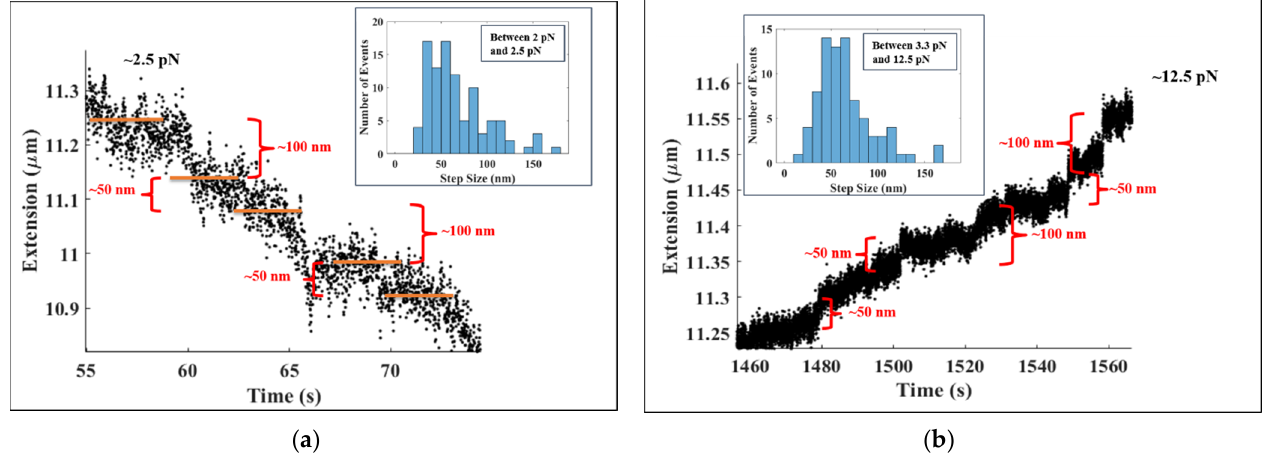
Figure 3. ( a ) The figure shows tether extension changes corresponding to histone-DNA complexation events at a force of ~2.5 pN. These data are from the region between Arrow A and Arrow B of Figure 2a presented at a higher resolution. Note the decrease of the length of the λ -DNA in multiple integrals of ~50 nm, suggesting the binding of core histone octameric units to the DNA tether. The horizontal lines (orange) indicate the step plateaus. Inset: Distribution of step sizes during the compaction of the DNA tether from 1 s to 400 s where the force range was between 2 pN and 2.5 pN. There were 99 steps in the distribution. Among them, 52 steps—more than 50% of the total—fall between 30 nm and 60 nm, with mean step size of ~47.2 ± 9.7 nm. Additionally, between 85 nm and 115 nm, we found 18 steps (~18% of the total) with a mean step size of ~99.9 ± 9.1 nm. ( b ) The figure shows the disruption events at a force of ~12.5 pN—data from Arrow D of Figure 2b—at higher resolution. Observe the extension increases upon each disruption step occurring in multiple integrals of ~50 nm, suggesting the mechanically induced unraveling of nucleosomes from the DNA tether. Inset: Distribution of step sizes during the decompaction of the DNA tether from 533 s to 1616 s, where the force range was between 3.3 pN and 12.5 pN. There were 80 steps in the distribution. Among them, 41 steps—more than 50% of the total—fell between 40 nm and 70 nm, with mean step size of ~53.7 ± 9.7 nm. Additionally, between 85 nm and 115 nm, we found 12 steps (~14% of the total) with a mean step size of ~97.5 ± 8.6 nm.